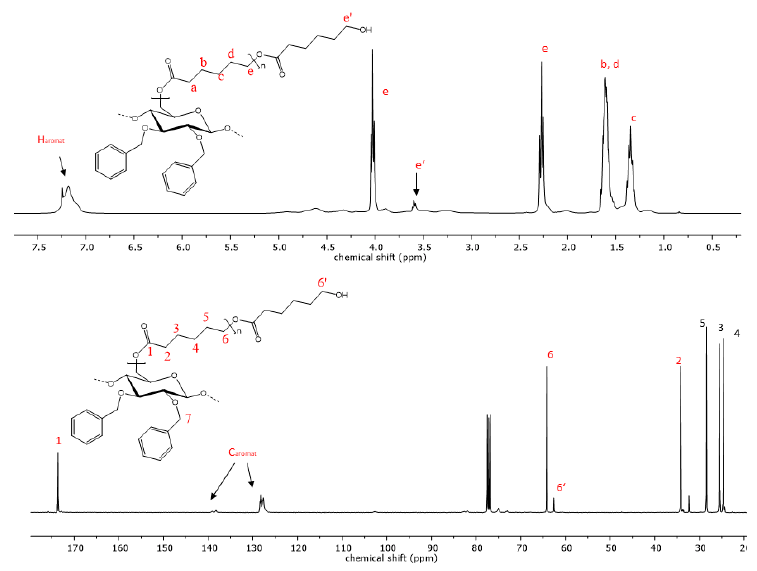
Figure 4. Representative 1 H- and 13 C-NMR spectrum of copolymer 9 with PCL sidechains.